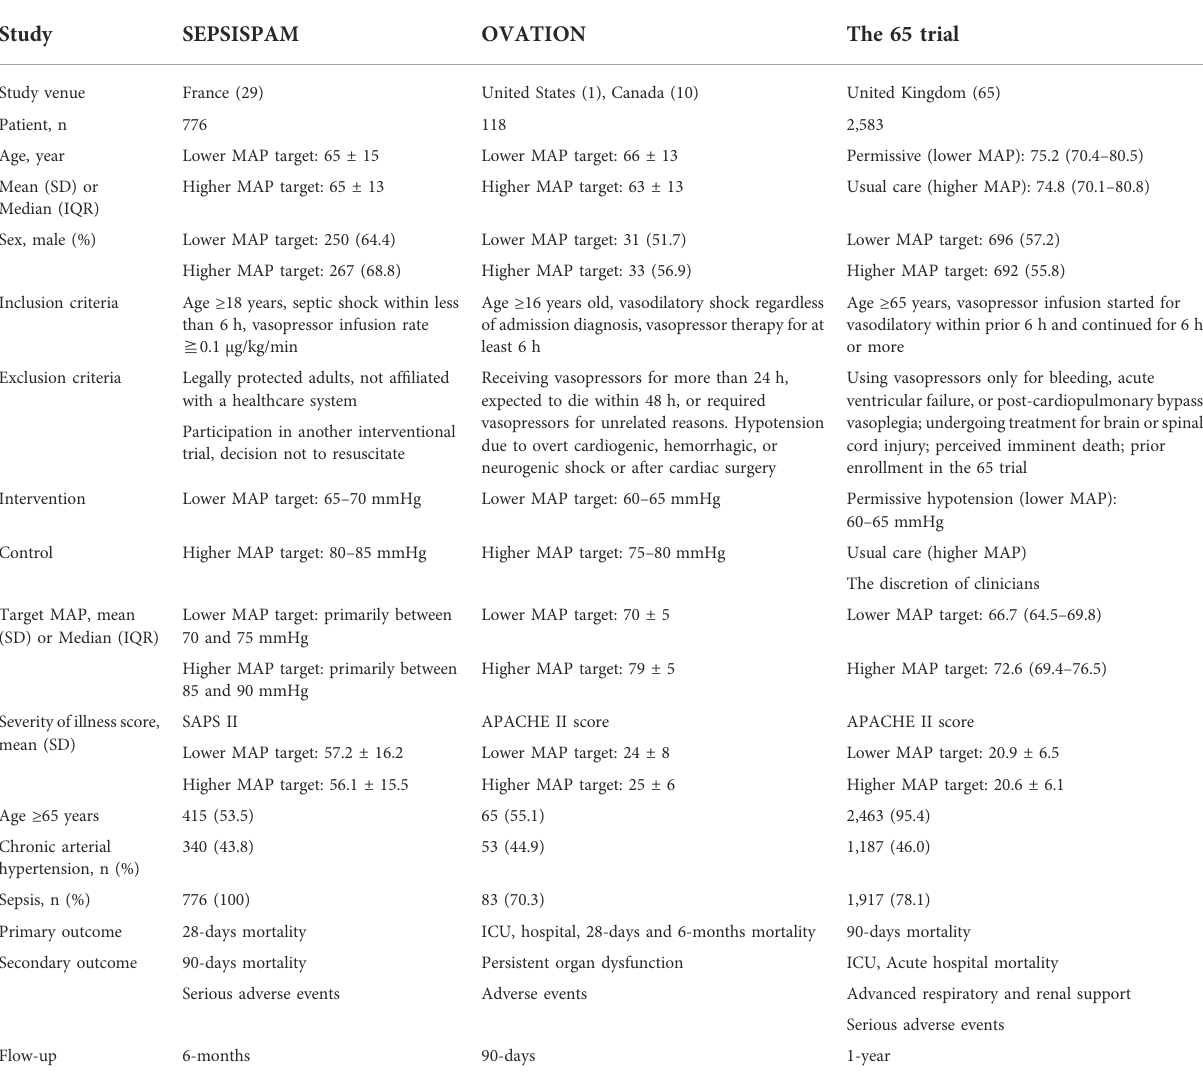
TABLE 1 Characteristics of the included randomized controlled